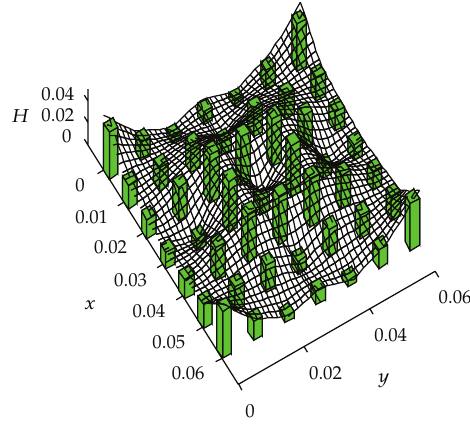
Figure 4: Fin heights